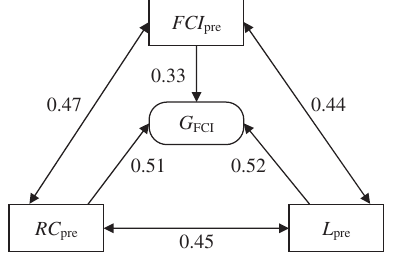
FIG. 3. Spearman’s rank correlation between single student normalized FCI gain ( G FCI ) and the three pretest variables for all the students ( n ¼ 131 ): representational consistency on the R-FCI ( RC pre ), the FCI score ( FCI pre ), and the Lawson test score ( L pre ). All correlations are statistically significant ( p < 0 : 001 ).